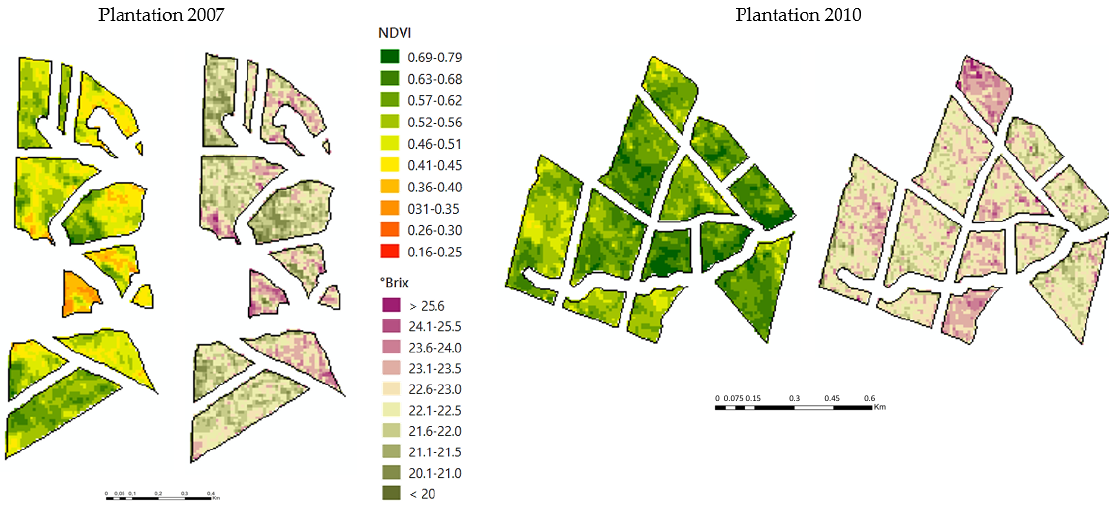
Figure 11. NDVI and ◦ Brix model maps, 2017